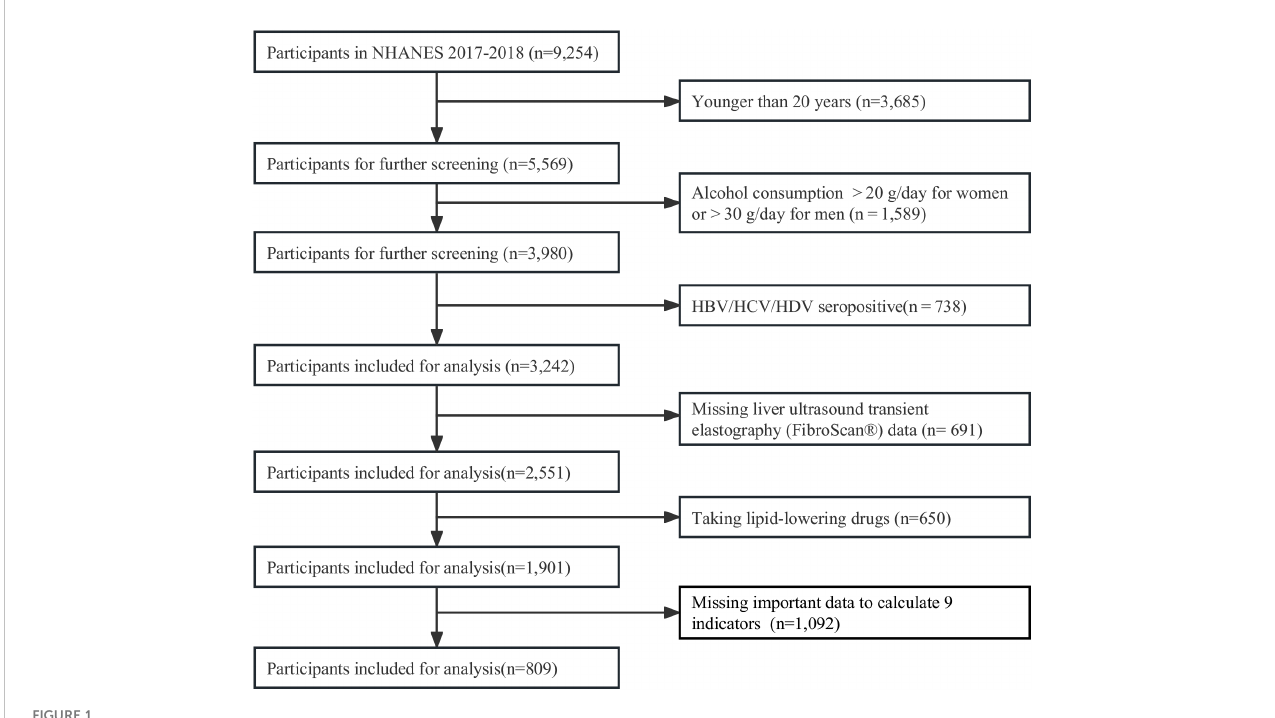
FIGURE 1 Flow chart for the selection of participants in the cross-sectional